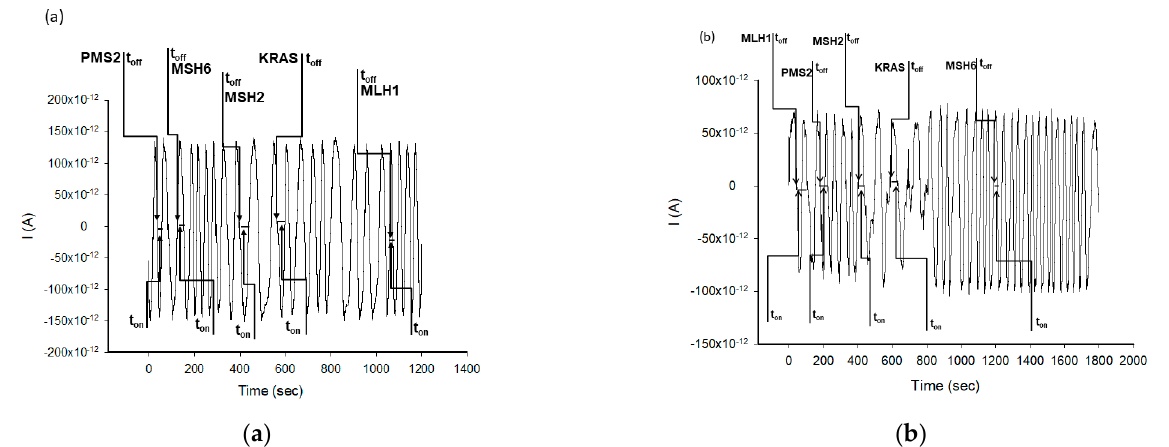
Figure 4. Examples of diagrams obtained for the screening tests of tumoral tissue using the stochastic sensors based on: ( a ) MD/EGR-1 and ( b ) MD/EGR-2.